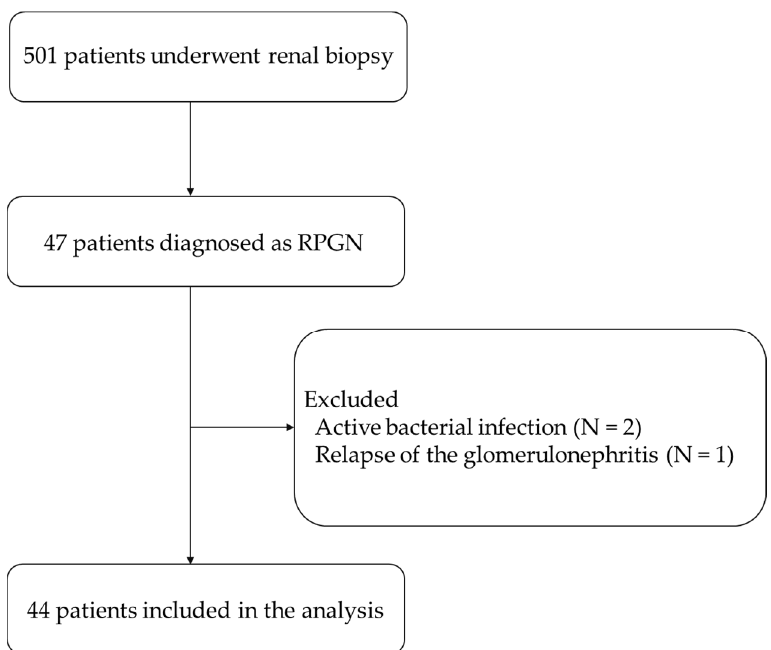
Figure 1. Study design. Of the 501 patients who underwent renal biopsy, 44 patients were included in the analysis.